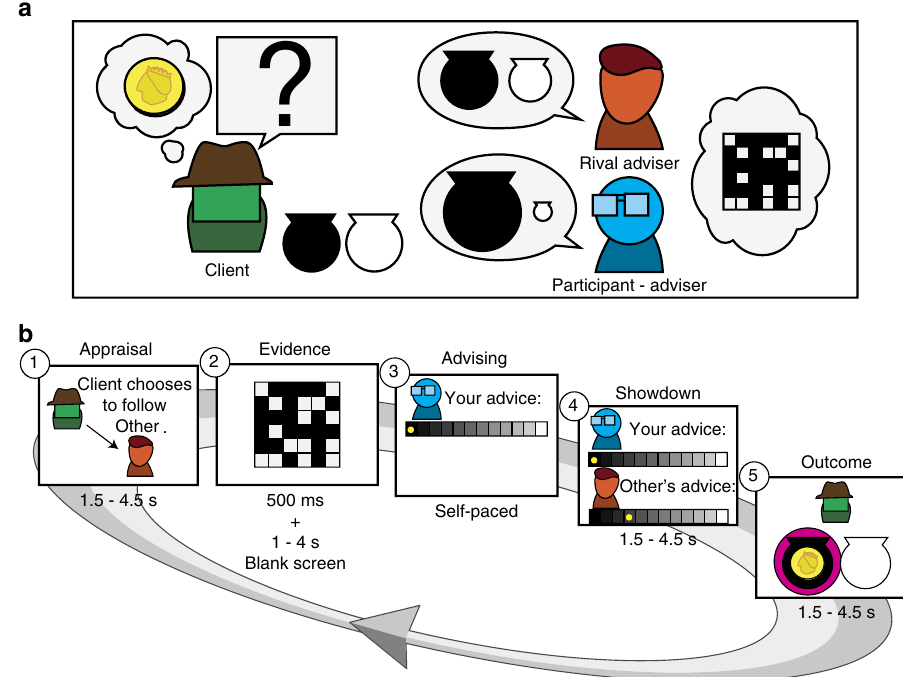
Fig. 1 Experimental design. a Participants were engaged in an advice giving task. In this task, a client is looking for a coin hidden in a black or white urn. He relies on advice from two advisers (the participant (blue) and a computer-generated rival adviser (red)). The advisers, but not the client, have access to information regarding the probability of the coin location. The client considers the advisers ’ previous success and current con fi dence when choosing an adviser to follow on each trial. b Each trial contains fi ve stages. (1) Appraisal: in the beginning of each trial the client chooses the adviser he is going to follow on the commencing trial (and consequently which adviser is ignored). (2) Evidence: the participant (and the rival) then sees a grid of black and white squares, whose ratio represents the probability of the coin being in the black urn. (3) Advising: the participant states his advice on coin location using a 10 levels con fi dence scale ranging from 'de fi nitely in the black urn' (5B) to 'de fi nitely in the white urn' (5 W). (4) Showdown: both advisers ’ opinion is displayed. (5) Outcome: the content of the urn suggested by the selected adviser (magenta circle) is revealed. The next trial starts with appraisal by client based on the history of con fi dence and success. The stages timings indicated are from the fMRI experiment, where jitter was introduced between stages. See supplementary materials for online and lab stages timings. An interactive demo of the experiment can be viewed at http://www.urihertz.net/